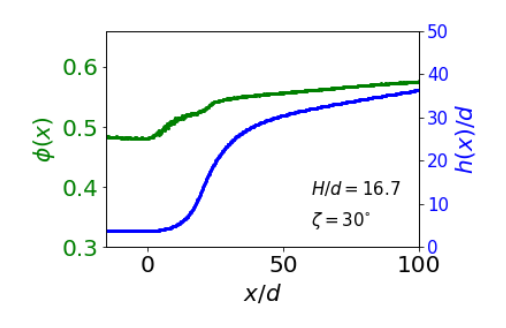
Figure 4. Free-surface (blue color) and depth-averaged volume fraction (green color) profiles along the chute in the vicinity of the granular jump, measured by the X-ray technique: example for H / d = 16 . 7 and ζ = 30 ◦ (glass beads). The position x = 0 corresponds to the beginning of the